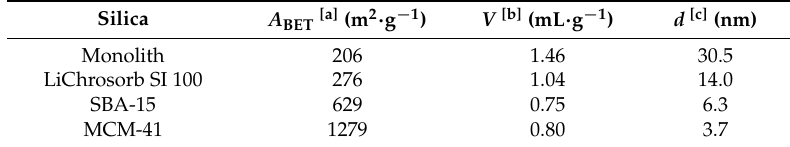
Table 1. Textural properties of porous silica materials.